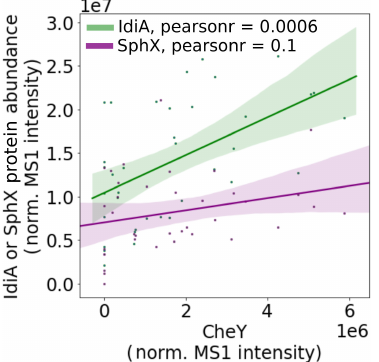
Figure 8. CheY is positively correlated with the iron stress biomarker IdiA but has a weaker association with the phosphate stress biomarker SphX. This suggests that it might be involved in iron acquisition, for instance by helping colonies to move dust par- ticles to the colony center. Pearson linear correlation coefficients ( r values) are provided ( p value for IdiA = 6 × 10 − 4 , SphX = 0.1). Shaded bars indicate 95% confidence intervals.